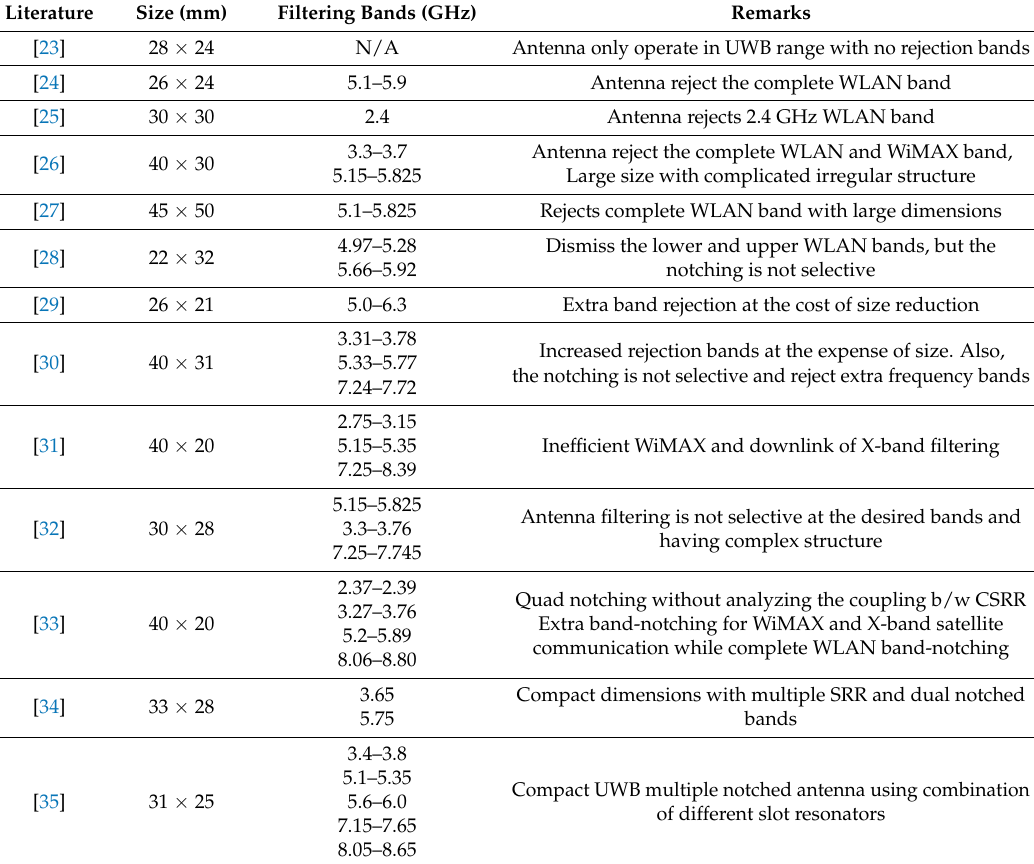
Table 5. Comparison between proposed and recently reported UWB antennas in the